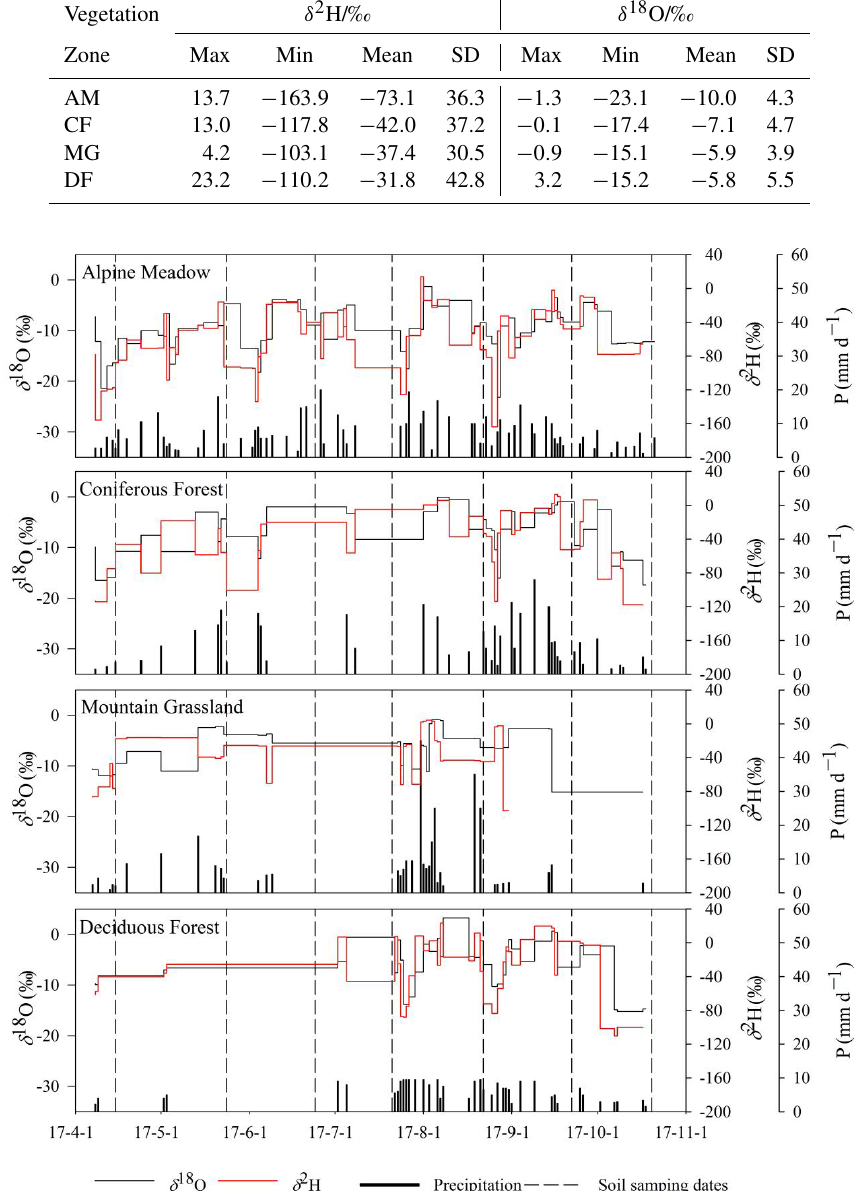
Figure 3. Time series of rainfall and isotope characteristics in different vegetation zones of the Xiying River basin, with dotted lines indicating the date of soil water